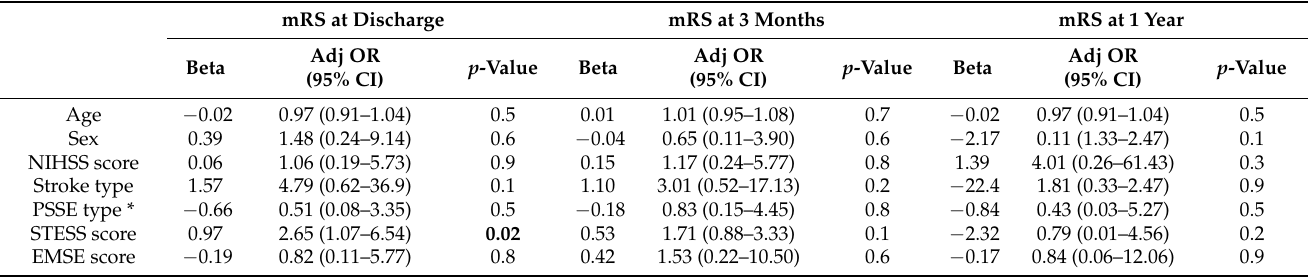
Table 5. Multivariable logistic regression model (adjusted OR and 95% CI for mRS > 2 at discharge, at 3 months, and at 1 year, n =